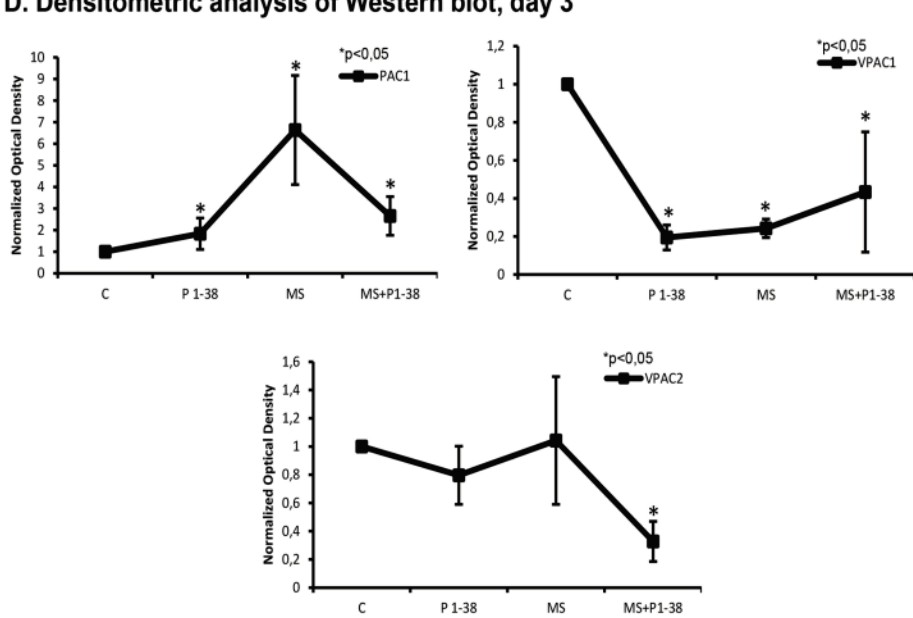
Figure 3. Expression of preproPACAP and PACAP receptors after PACAP administration and/or mechanical load in chondrifying micromass cultures. For RT-PCR ( A ) reactions GAPDH and for Western blot ( C ) reactions Actin was used as control. Optical density of signals was measured and results were normalised to the optical density of controls. For panels ( A , C ) numbers below signals represent integrated densities of signals determined by ImageJ software. Representative data of three independent experiments; ( B , D ) Statistical analysis of RT-PCR and Western blot data. All data are the average of at least three different experiments. Statistical analysis was performed by Student’s t -test. All data were normalized on GAPDH/Actin and data are expressed as mean ± SEM. Asterisks indicate significant (* p < 0.05) alteration of expression as compared to the respective control in all panels (C, control; P1–38, PACAP 1–38; MS; mechanical